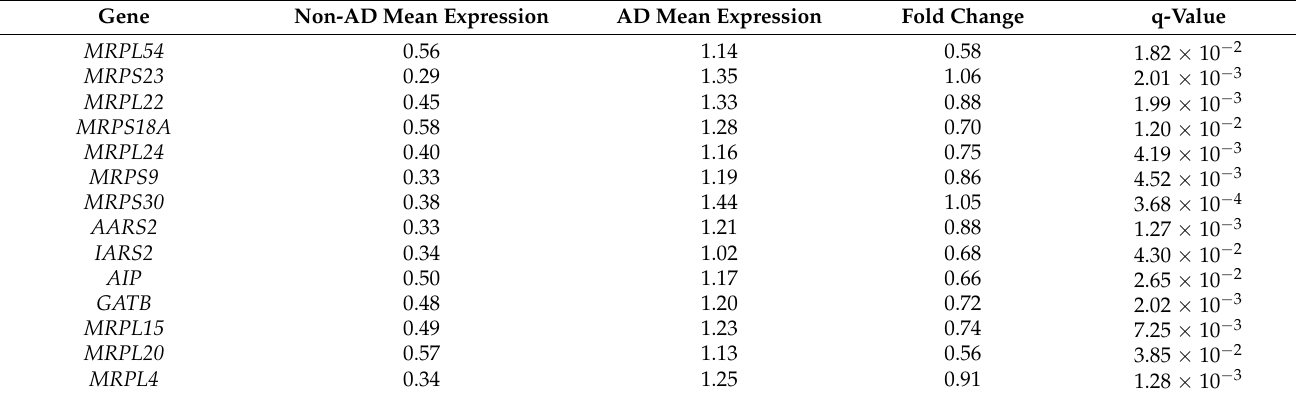
Table 4. DEGs included in the “mitochondrial translation” biological process.